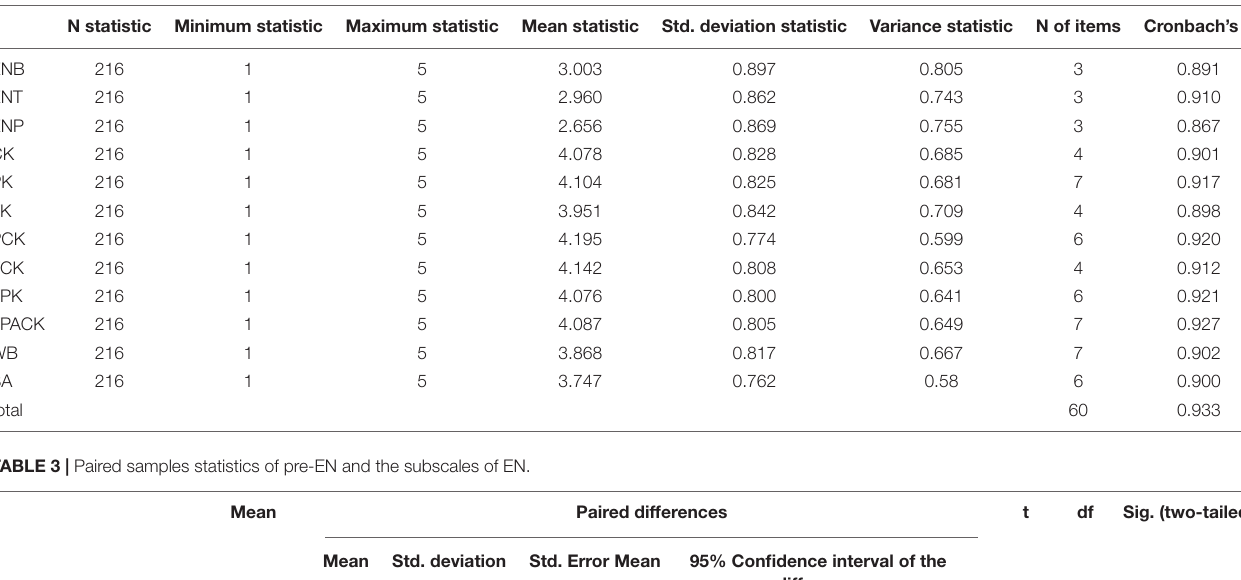
TABLE 3 | Paired samples statistics of pre-EN and the subscales of EN. Mean Paired differences t df Sig. (two-tailed) Mean Std. deviation Std. Error Mean 95% Confidence interval of the difference Lower